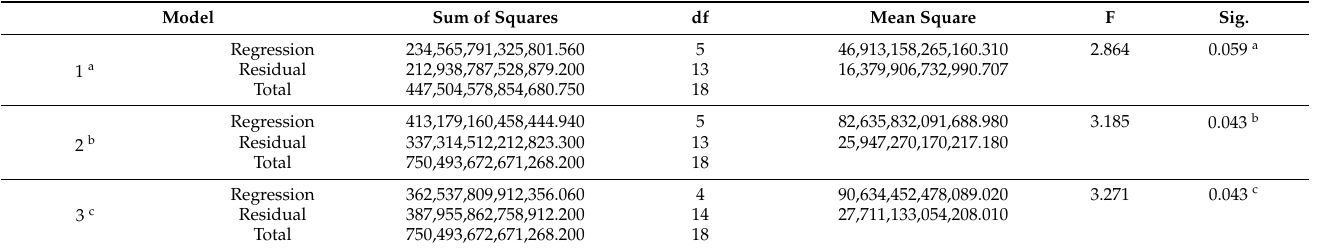
Table 9. ANOVA results for the regression